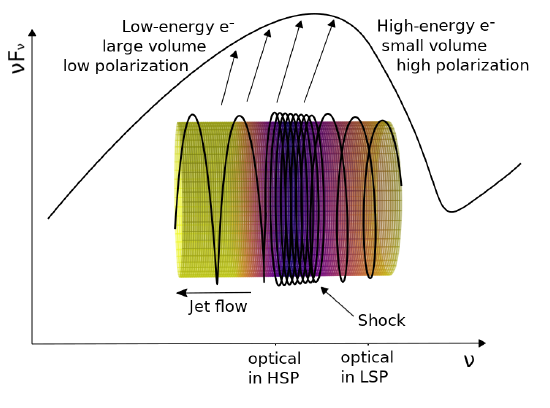
Figure 3. Sketch of the shock-in-jet scenario proposed by Angelakis et al.